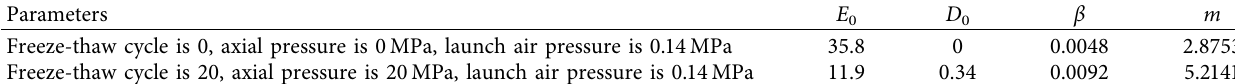
Table 4: Parameter values.